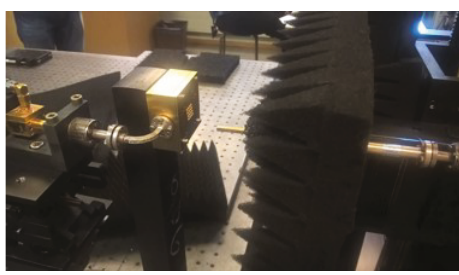
Figure 13: Assembled antenna in the measurement setup.